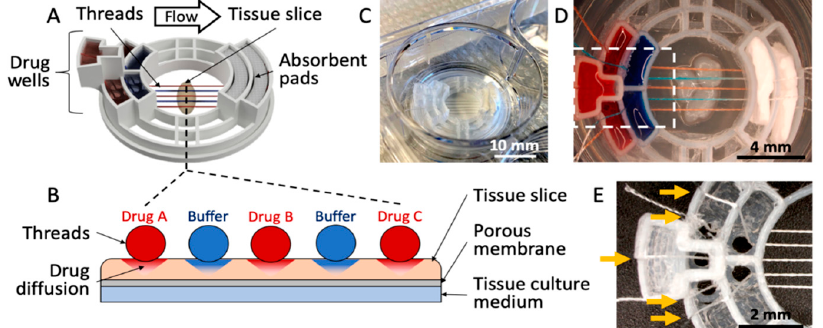
Figure 1. Microfluidic thread device for drug delivery. ( A ) 3D rendering of the device. ( B ) Cross- sectional illustration of the thread-to-tissue fluid transfer concept. ( C ) Photograph of a finished device inside a well of a 6-well culture plate. ( D ) Photograph of the device delivering red and blue dyes to fixed glioblastoma tissue. ( E ) Close-up photograph of an empty device (approximately the area boxed in ( D ), showing the thread-alignment holes at the bottom of the drug wells and the thread-holding slits (yellow arrows) above each well.